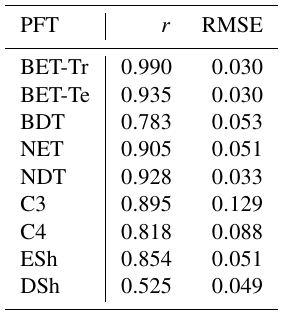
Table 4. Goodness of fits for the RED equilibrium coverages to the coverages from ESA LC_CCI dataset across PFTs. r represents the Pearson correlation coefficient, after weighting by the grid-box area to account for latitudinal variation in grid-box areas.